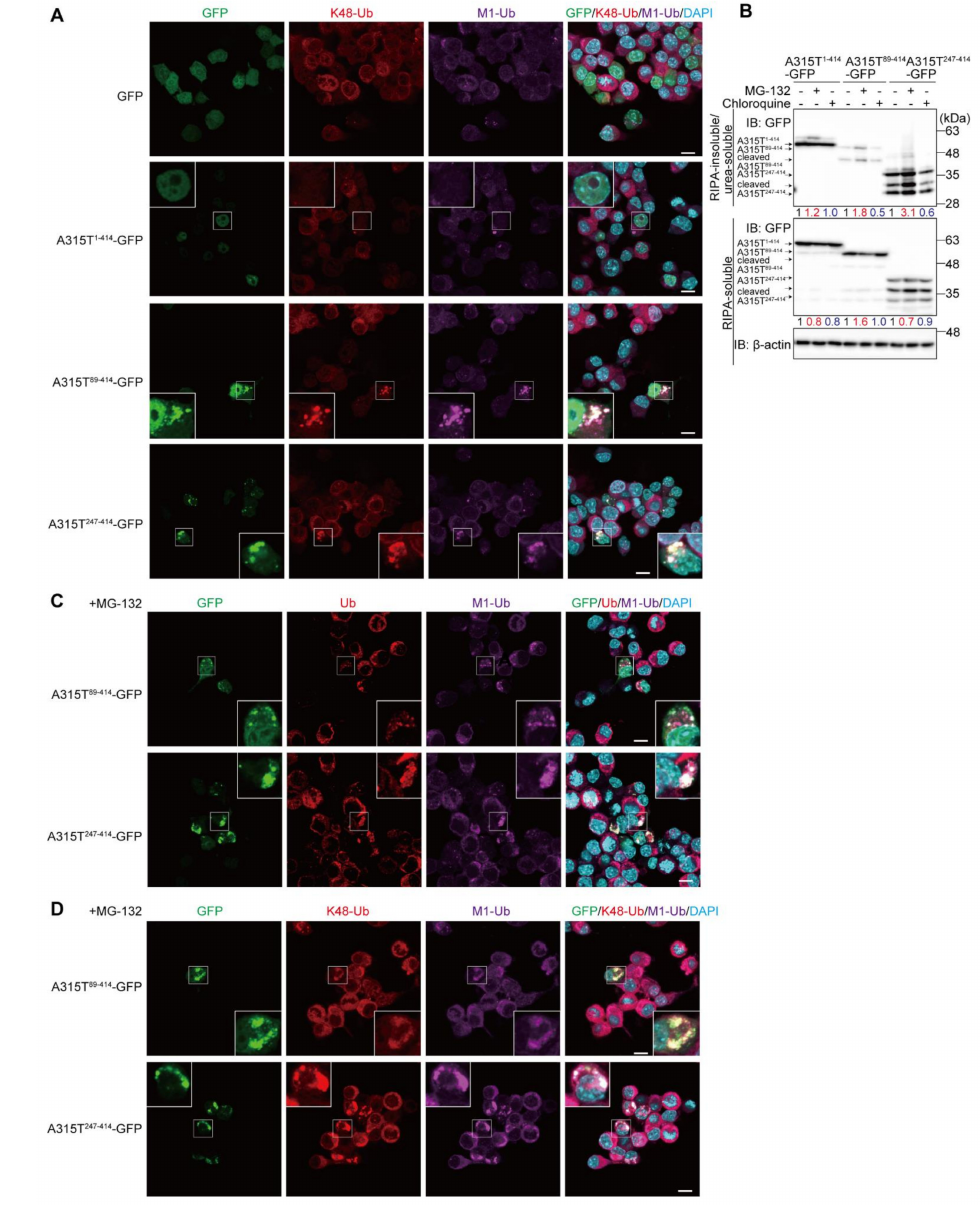
Figure 2. Cytoplasmic aggregates of truncated TDP-43 include M1- and K48-linked ubiquitin chains. ( A ) GFP and various A315T mutants of TDP-43-GFP were transiently expressed in Neuro2a cells, and the colocalization of K48-ubiquitin (K48-Ub) and linear ubiquitin (M1-Ub) was examined. ( B ) The suppression of proteasome activity increases insoluble A315T-GFPs. Plasmids encoding A315T 1-414 - GFP-, A315T 89-414 -GFP-, or A315T 247-414 -GFP were expressed in Neuro2a cells, which were treated with 2 µ M MG-132 or 50 µ M chloroquine for 6 h. The detergent-insoluble and 6 M urea-soluble fractions were immunoblotted with an anti-GFP antibody. Taking the intensity of the control as 1.0, the relative intensities are shown. ( C , D ) Enhanced aggregation of A315T-GFPs in the MG-132-treated Neuro2a cells. The colocalization of ALS-associated TDP-43 mutants with pan- and M1-ubiquitins ( C ), or K48- and M1-ubiquitins ( D ) was analyzed by immunofluorescent staining. ( A , C , D ) Bars = 10 µ m. Similarly, the colocalization of the K63- and M1-ubiquitins was detected in the cytoplas- mic aggregates of A315T 89-414 -GFP and A315T 247-414 -GFP, but not GFP and A315T 1-414 -GFP (Figure 3A). In the presence of MG-132, the cytoplasmic aggregates of A315T 89-414 -GFP and A315T 247-414 -GFP colocalized with K63- and M1-ubiquitins were increased (Figure 3B). Collectively, these results suggest that multiple ubiquitin chains such as M1-, K48-,